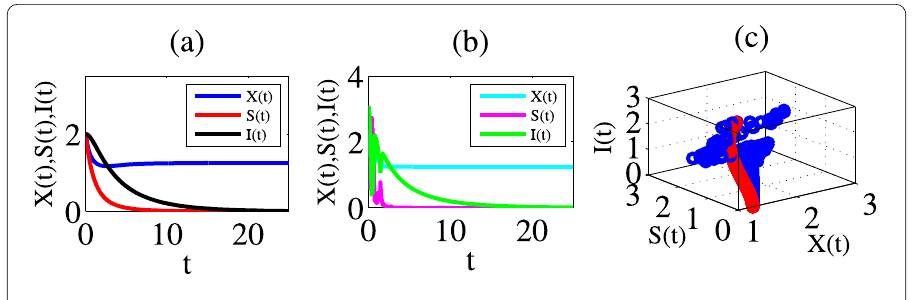
Figure 1 Time sequence diagram and phase portrait of model (2). (a) The deterministic model; (b) the Brownian motion model with σ 12 = σ 21 = σ = 0.5; (c) phase portrait: the red ◦ is corresponding to the deterministic model, while the blue ◦ represents the stochastic